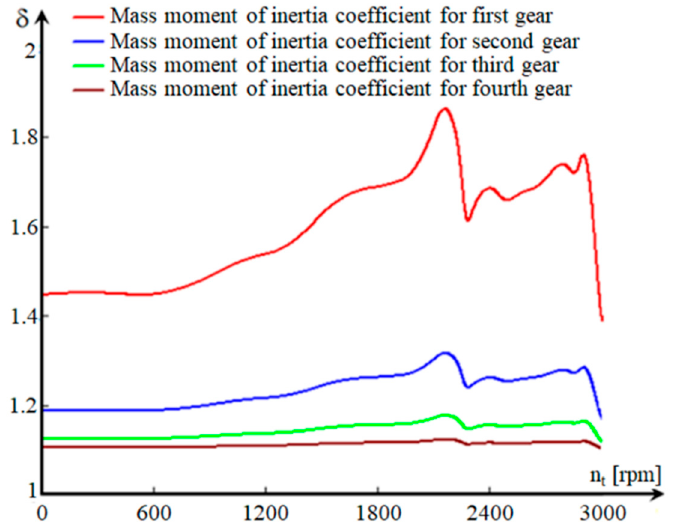
Figure 8. Variation of the mass moment of inertia coefficient ( δ ) depending on the turbine speed.